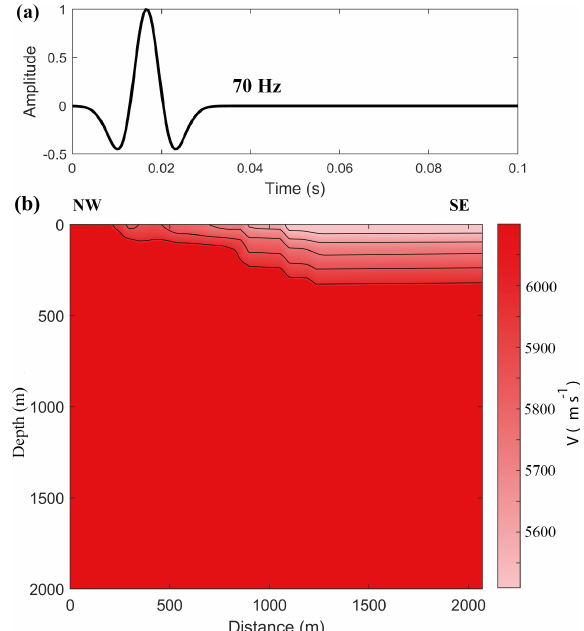
Figure 5. (a) A Ricker wavelet (70Hz) was chosen as the source wavelet, which generates forward propagating wave fields. (b) The migration velocity model used for the forward and backward prop- agations. The black lines are contour lines of the velocity values.